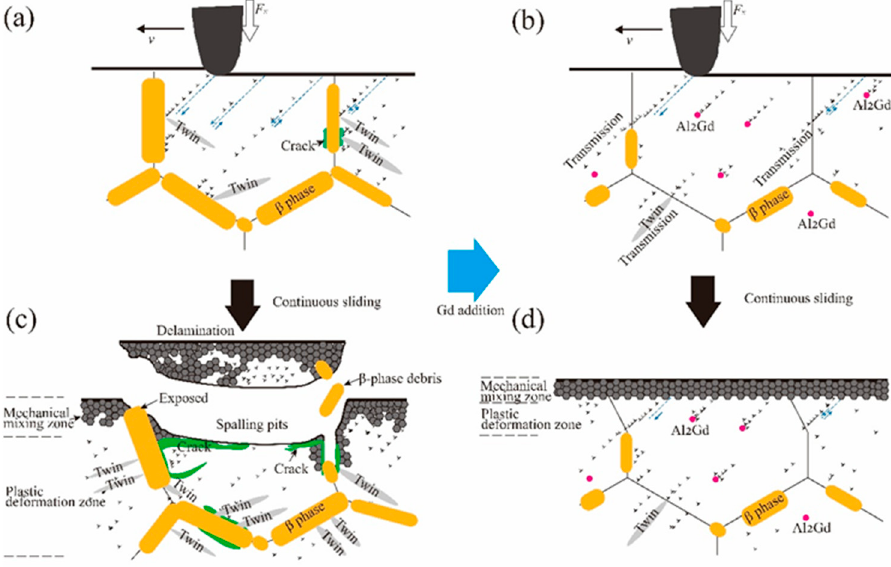
Figure 13. Schematic diagram illustrating the effect of Gd addition on the delamination wear pro- cess of surfacing magnesium alloys: ( a , c ) AZ91 alloy, ( b , d ) AZ91 + Gd alloy. of surfacing magnesium alloys: ( a , c ) AZ91 alloy, ( b , d ) AZ91 + Gd